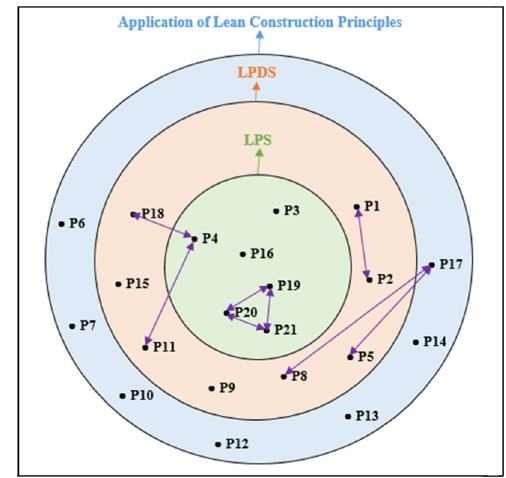
Fig. 1. Application map of lean construction